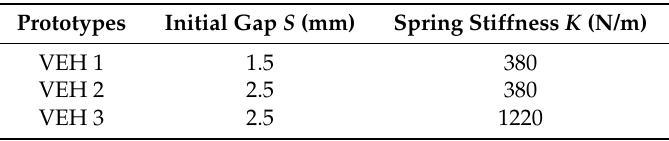
Figure 9. Experimental setup.